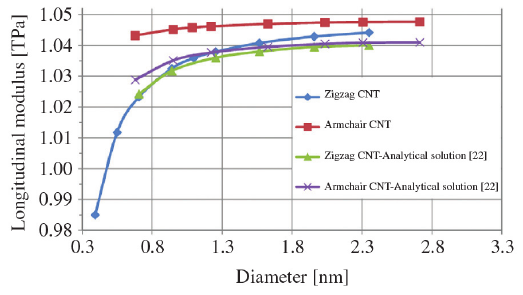
Figure 5. The longitudinal modulus of CNT in term of